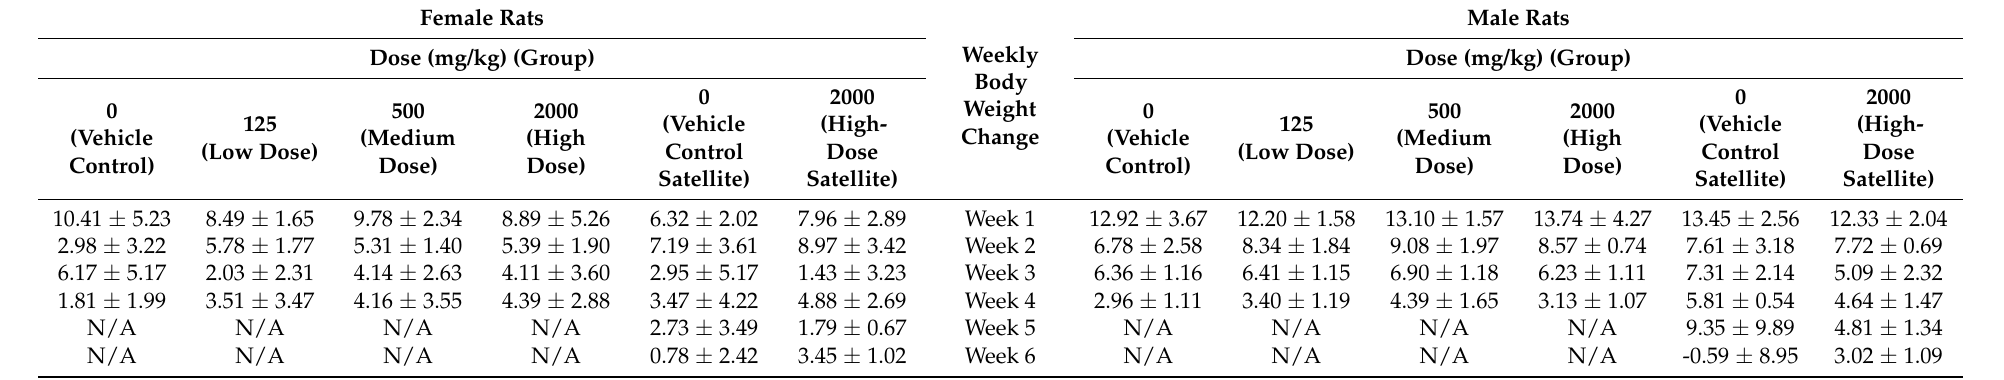
Table 3. Percentages of weekly body weight change (%) in female and male